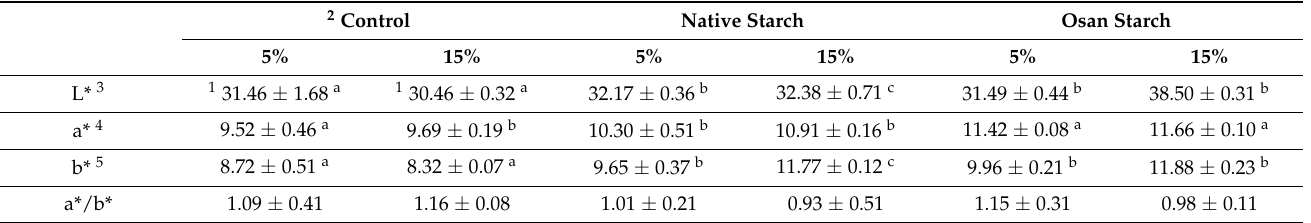
Table 8. The effect of octenyl-succinylated (Osan) corn starch, native starch, and animal fat on the color characteristics of cooked meat patties after 6 h.